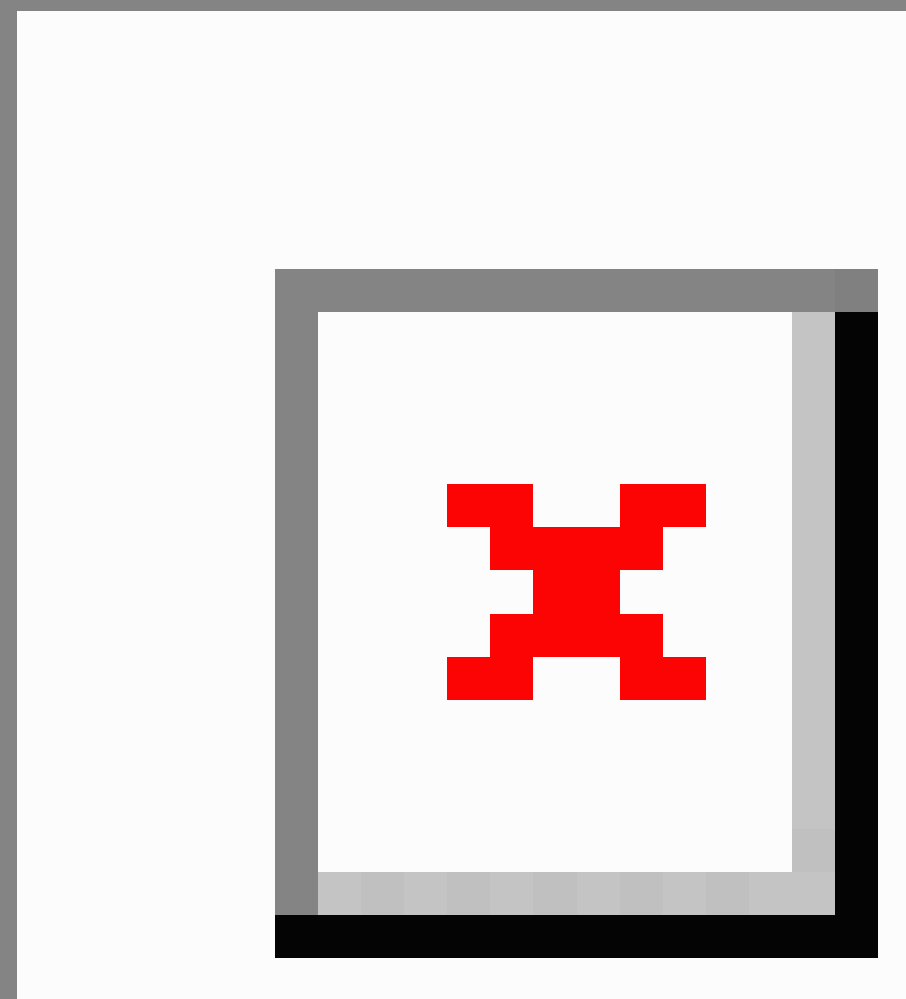
Figure 1. Four-step process for logging in to Secure